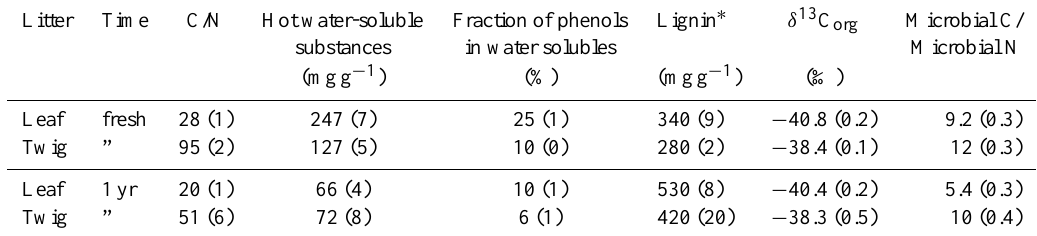
Table 2. Selected parameters of leaf and twig litter at the beginning and after 1yr of decomposition. Litter of both soil types are combined as their chemical parameters differed only marginally. The values are means ± standard errors. The number of replicates is ten for all parameters of litter quality and six for microbial C/N.